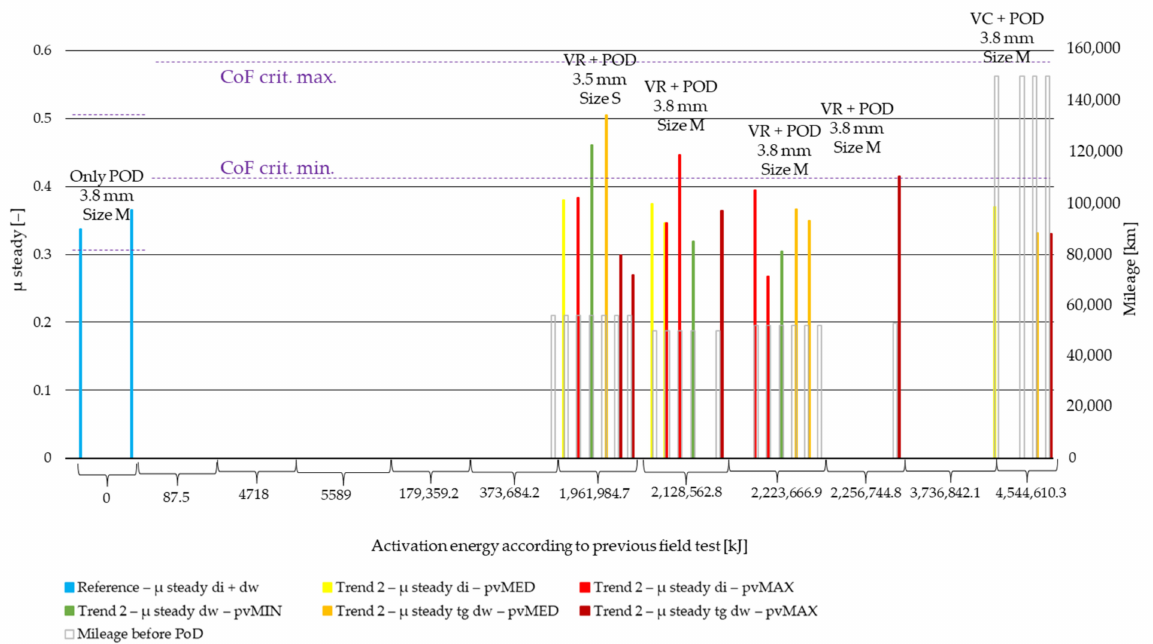
Figure 9. Steady state CoF values of PoD samples from ‘moderate’ field-test